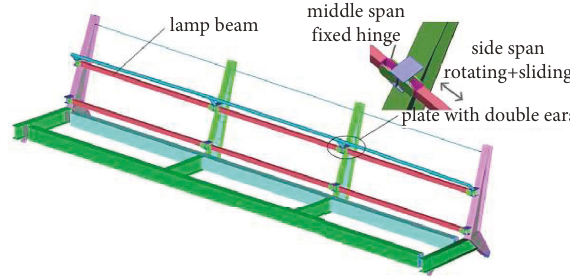
Figure 20: Catwalk with lamps.